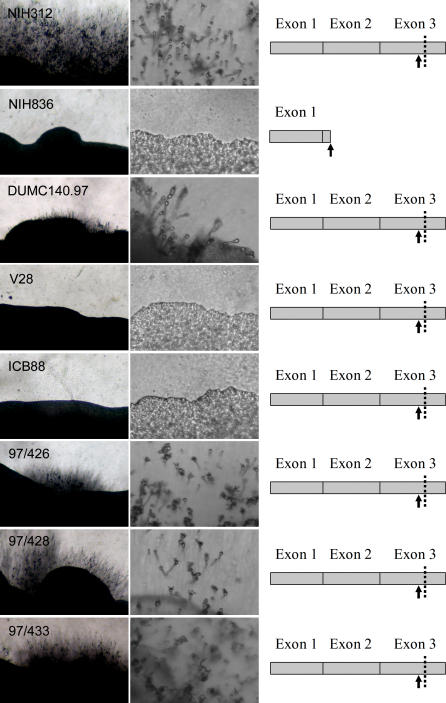

C. gattii Strains with a Premature C-Terminal Stop Codon in the SXI1α Gene Are FertileNatural α C. gattii VGIII isolates with variations in the C-terminus of the SXI1α gene mate with reference strain JEC20 to form mating hyphae and spores. From top to bottom are strains NIH312, NIH836, DUMC140.97, V28, ICB88, 97/426, 97/428, and 97/433. Mating filaments are shown in the left images (×40), and basidia with spores are shown in the right images (×200). Diagrams at far right show the corresponding SXI1α alleles, the location of the stop codon (arrow), and the location of the corresponding deletion site of the truncated SXI1Dα allele (dashed line).